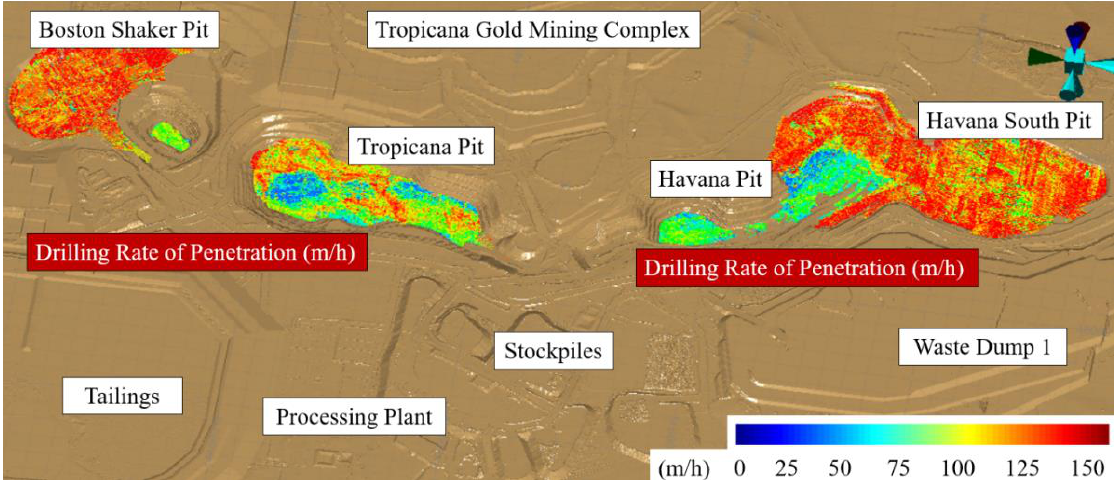
Figure 1. Components of the Tropicana Gold mining complex and a heat map of drilling rate of penetration (ROP) retrieved from measurement while drilling (MWD).